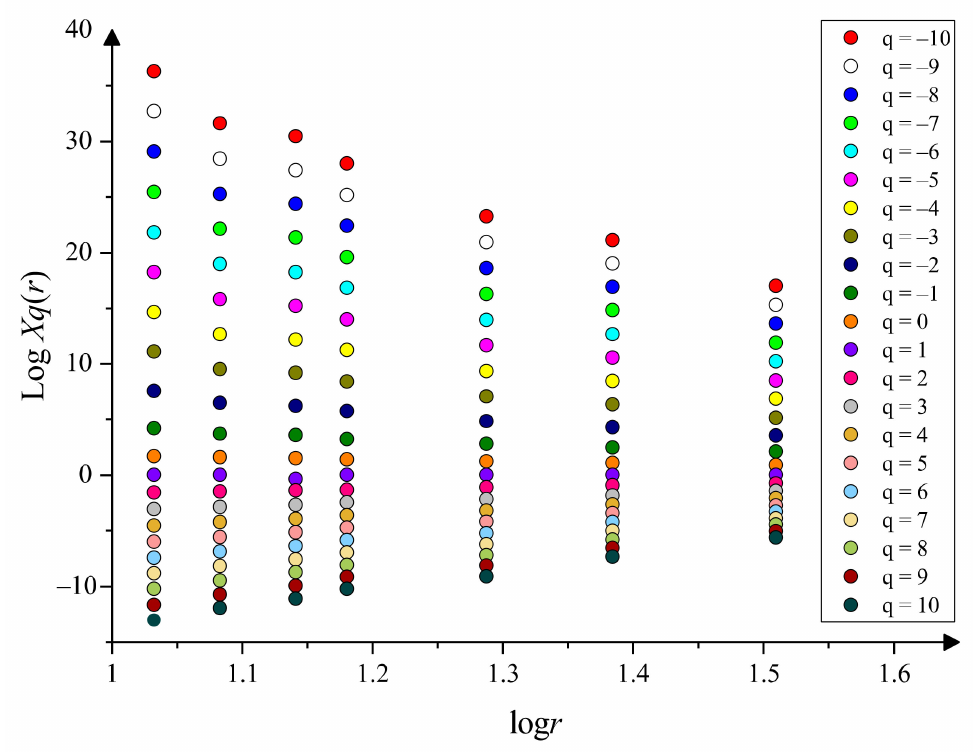
Figure 7. The distribution of logX q ( r ) as a function of log r